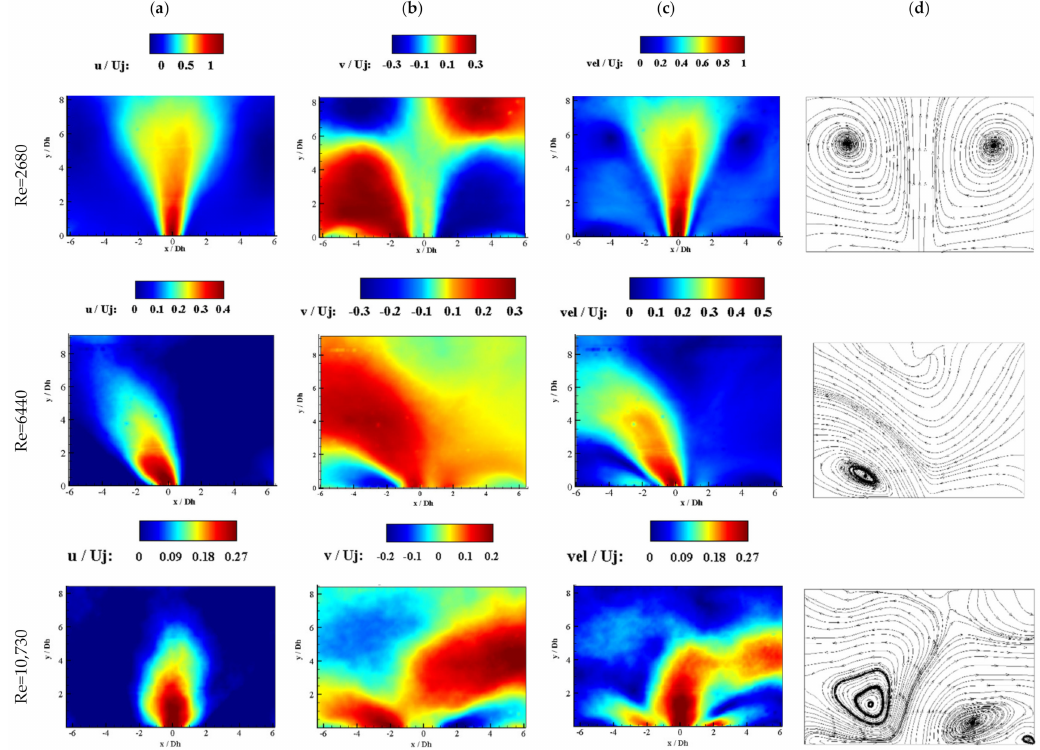
Figure 7. Time average of ( a ) streamwise velocity, ( b ) transverse velocity, ( c ) velocity magnitude, and ( d ) streamline for fully confined external region at Re = 2680, 6440, and 10,730 and z / D h = 0. For Re = 10,730, the jet was generated by the fluidic oscillator and changed the direction from right to left, so the final time-averaged pattern was inclined toward the centerline with the highest velocities. However, the jet was not symmetrically distributed, but almost a steady and continuous jet was obtained in the time-averaged results (Figure